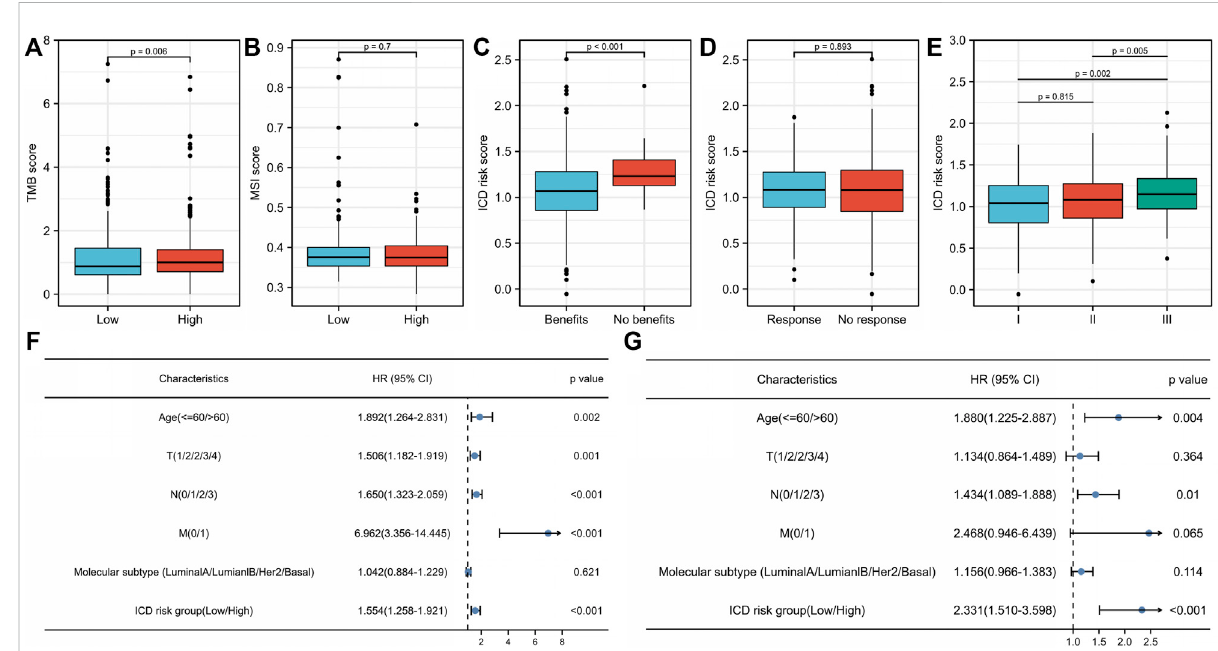
FIGURE 7 Association of the immunogenic cell death (ICD) risk signature with clinical characteristics in The Cancer Genome Atlas (TCGA) breast invasive cancer (BRCA) cohort. The (A) tumor mutational burden (TMB) score and (B) microsatellite instability (MSI) score in low- and high-ICD-related risk groups. The ICD risk score between (C) bene fi t and no bene fi t groups, (D) response and no response groups based on Tumor Immune Dysfunction andExclusion(TIDE)analysis. (E) DifferenceofICD riskscoreindifferentcancerstages. (F) Univariateand (G) multivariateCoxanalysesevaluate the independent prognostic value of the ICD risk signature in patients with breast